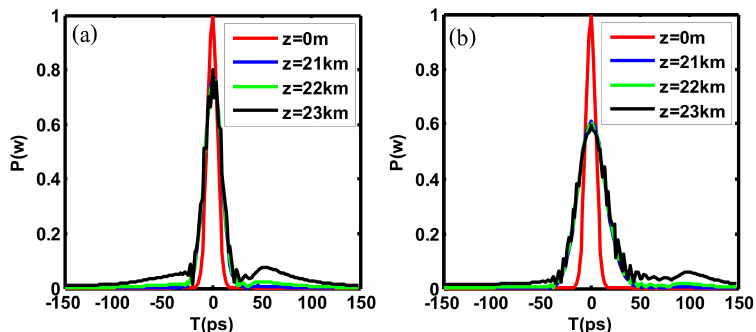
Figure 5. The pulse waveform comparison at different propagation distances. ( a ) The first case in Table 2; and ( b ) the second case in Table 2.